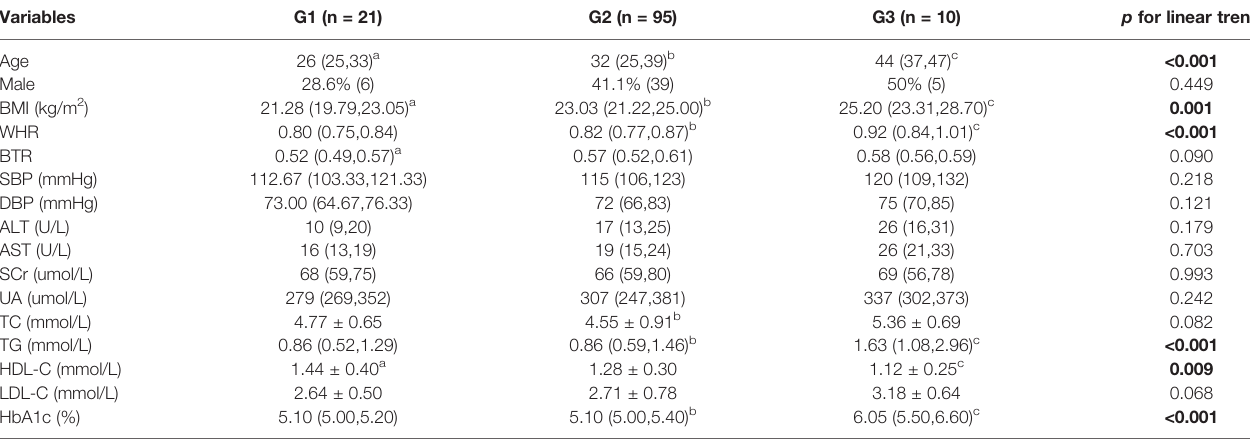
TABLE 1 | Clinical and laboratory characteristics of participants by different glucose metabolic state and time to glucose peak at baseline.